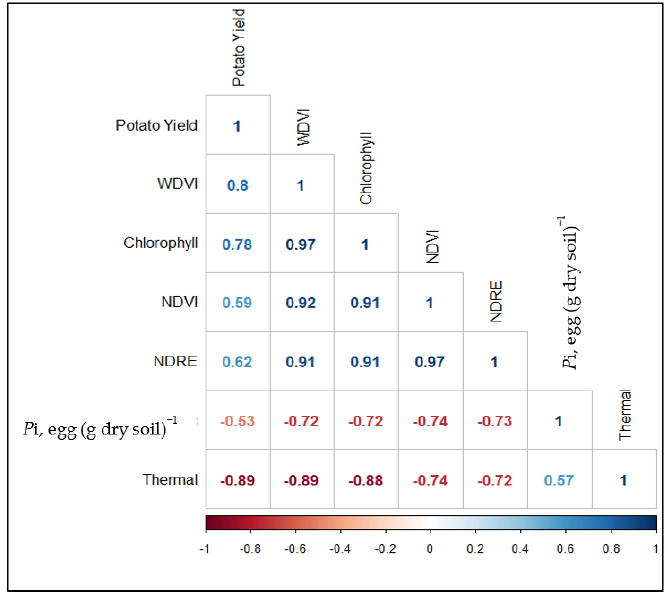
Figure 3. Correlation heatmap matrix of different variables taken from the field experiment (Ini- tial population, P i = eggs (g dry soil) − 1 and fresh tuber yield) and from an unmanned vehicle